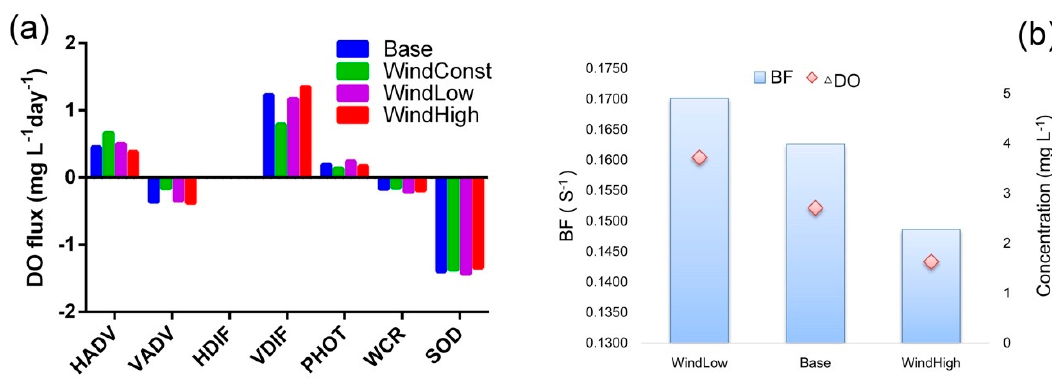
Figure 14. ( a ) DO budget of the base run and wind runs in the bottom layer of the Modaomen hypoxic zone during June–August. ( b ) BF and DO concentration di ff erence between the surface and bottom zone during June–August. ( b ) BF and DO concentration difference between the surface and bottom layers of the base and wind runs in the Modaomen hypoxic layers of the base and wind runs in the Modaomen hypoxic zone.